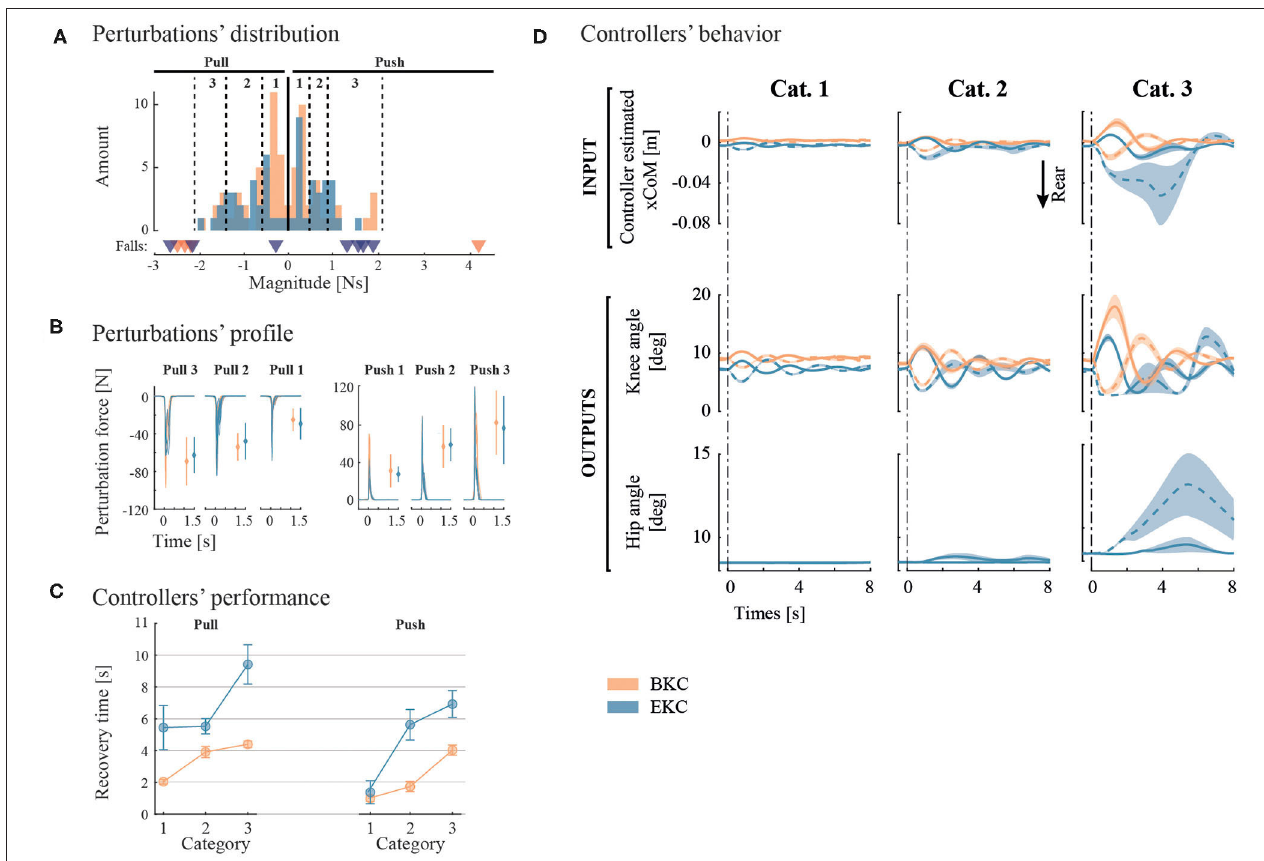
FIGURE 5 | Pulse perturbation results and controllers’ outputs. (A) The perturbations of similar magnitude are grouped in 3 categories for each direction. The thresholds of each category are represented by the vertical dotted lines. Underneath the histograms, perturbations that led to a fall are presented by a triangle. (B) Individual perturbation force profiles are shown by category. In addition, the average and standard deviation of the maximum perturbation forces are shown with error bars. (C) Controllers’ performance is evaluated with the recovery time. (D) average system response of the two controllers subject to the 3 categories of perturbation Magnitudes. Solid lines represent posterior perturbations, while dotted lines denote anterior ones. Overall, the colors correspond to the controllers (orange for BKC and blue for EKC).